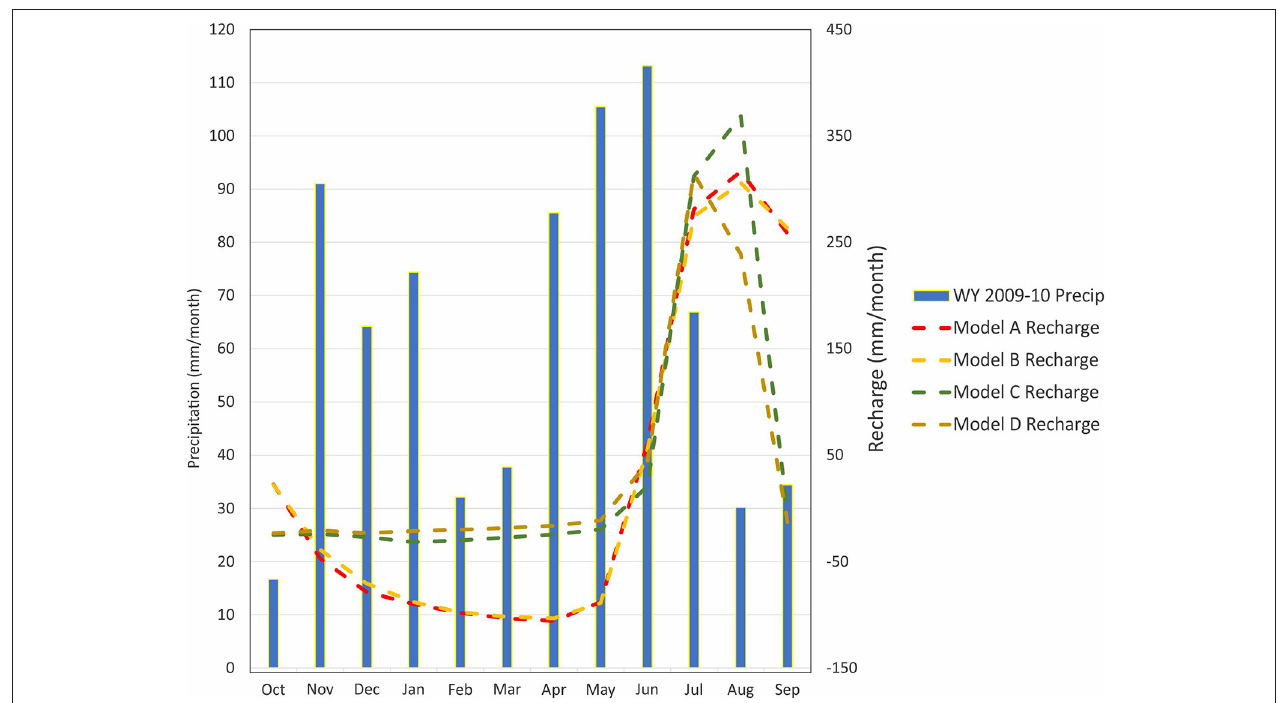
FIGURE 12 | Precipitation and simulated recharge for Models A, B, C and D for water year (WY) 2009–2010.